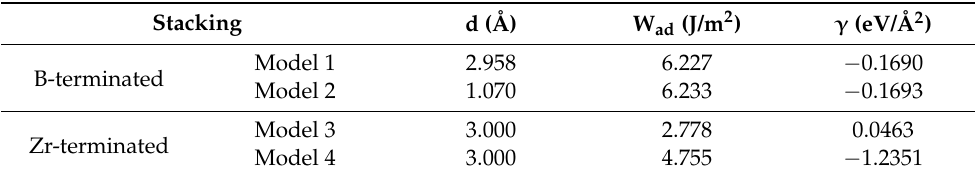
Table 1. The interface distance of the four interface models of the ZrB 2 /Mo multilayers, the ideal interface viscosity work, and the interface energy.